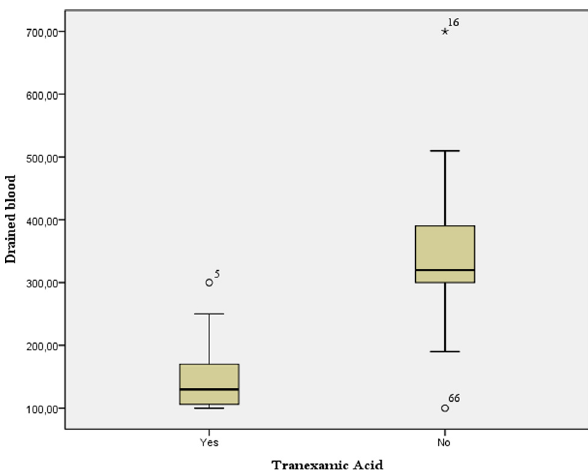
Figure 2: Drainage in the analyzed groups.